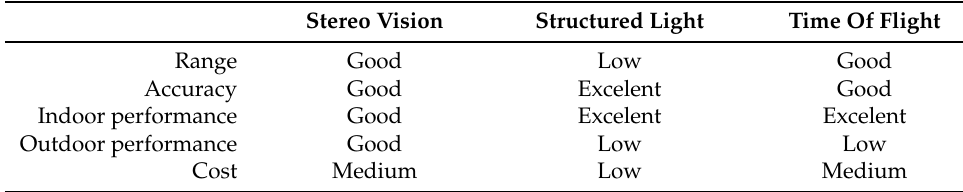
Table 4. Main methods for collecting depth data. Stereo Vision Structured Light Time Of Flight Range Good Low Good Accuracy Good Excelent Good Indoor performance Good Excelent Excelent Outdoor performance Good Low Low Cost Medium Low